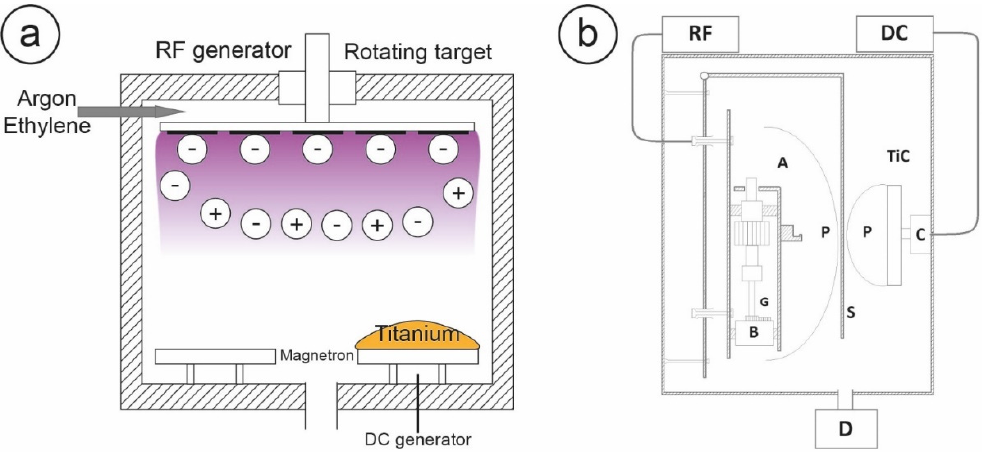
Figure 3. Panel ( a ): A general schematization of the Ion Plating Plasma Assisted (IPPA) apparatus. The sample holder containing the substrates to be treated is biased by a radiofrequency (RF) produced by the generator, while the magnetron sputtering device, on which a titanium target is placed, is powered by the Direct Current (DC) generator. Vacuum is applied to the chamber, followed by introduction of ethylene as carbon source: maintaining active both DC and RF, a plasma cloud is generated and produces the deposition on the substrates. Panel ( b ): the IPPA apparatus with the TiC target on the magnetron sputtering source, powered by variable direct current. The sample holder (A) containing the substrates biased by a constant RF produced by the generator, while the magnetron sputtering source (C) on which a TiC target is placed is powered by variable DC. Vacuum is applied to the chamber through the pump (D). Plasma clouds (P) are generated in front of the TiC target and the sample holder, and deposition is produced on the substrates. Reprinted from [63]. Copyright (2015), with permission from Elsevier.